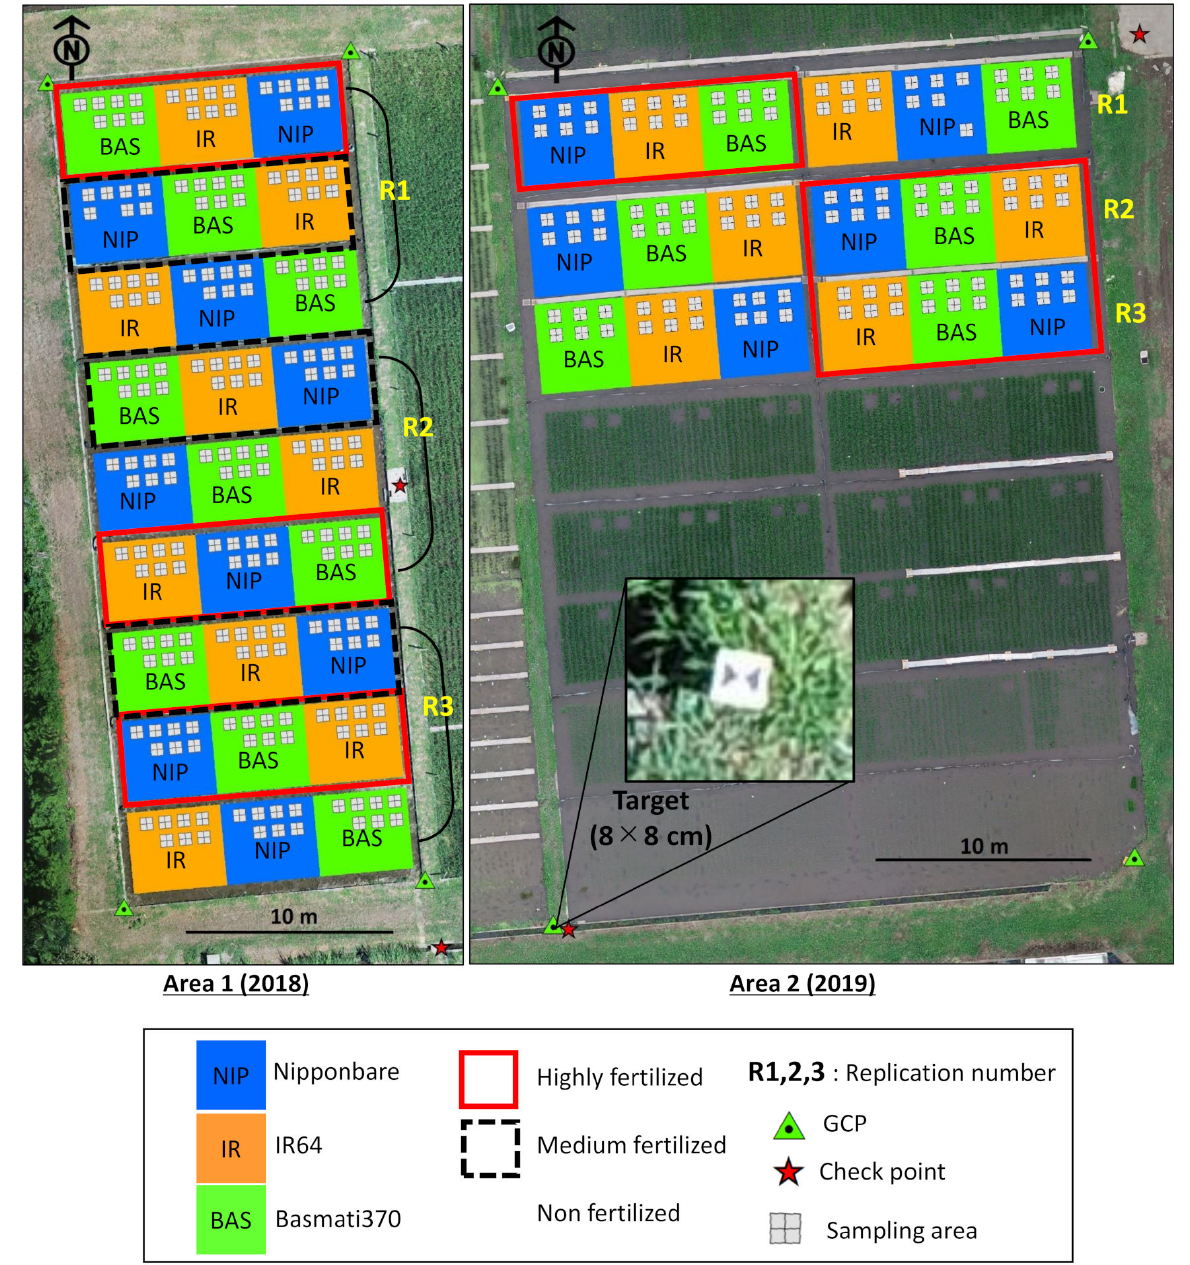
Figure 1. Study fields and layouts in 2018 and